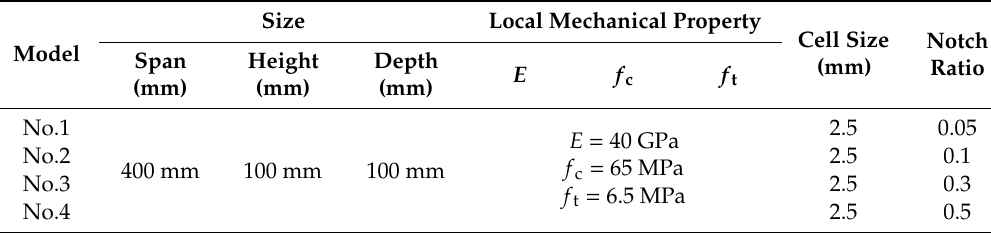
Table 7. Values of input parameters in the numerical analyses about notch ratio on three-point bending test.